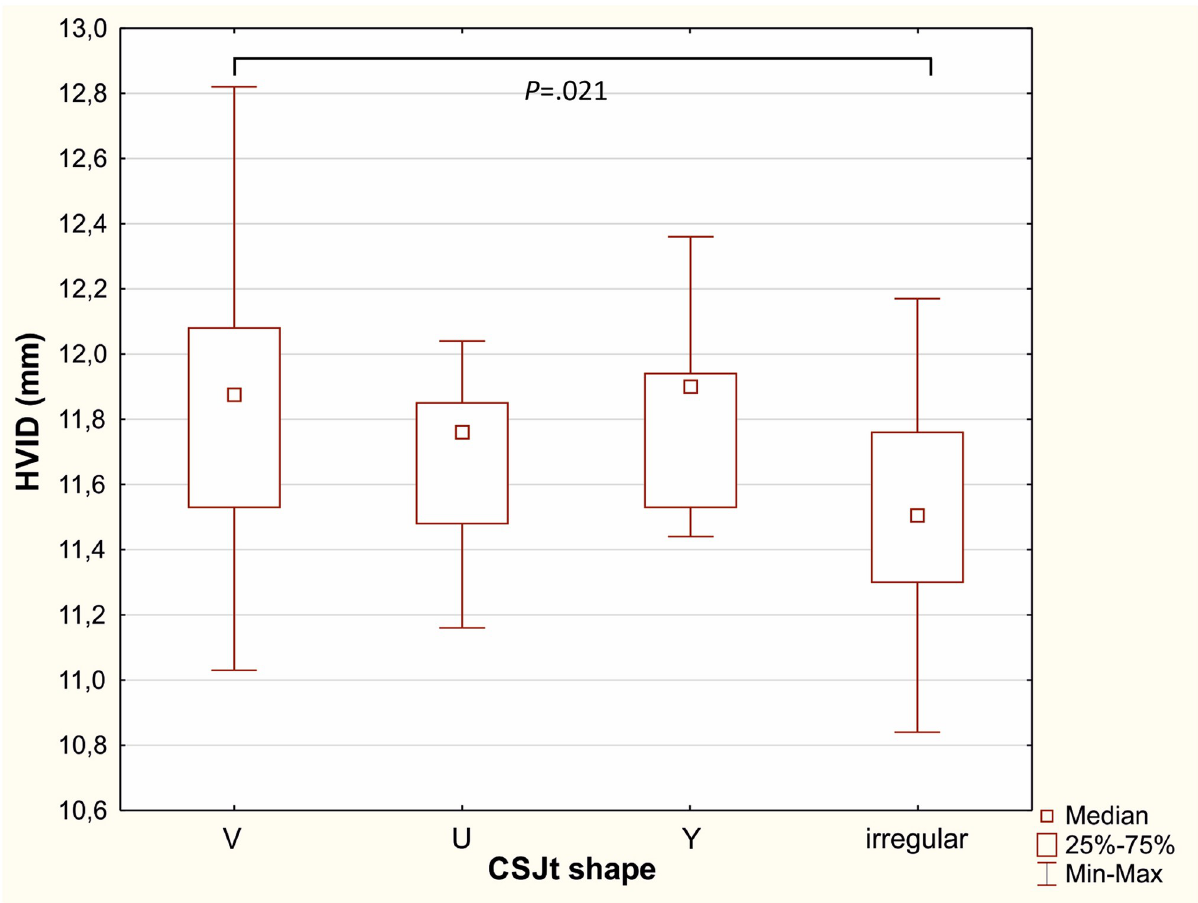
Fig 5. Box-plots of horizontal visible iris diameter (HVID) in eyes with different temporal corneo-scleral junction shape: V, U, Y and irregular ( P = .021, Kruskal-Wallis test).